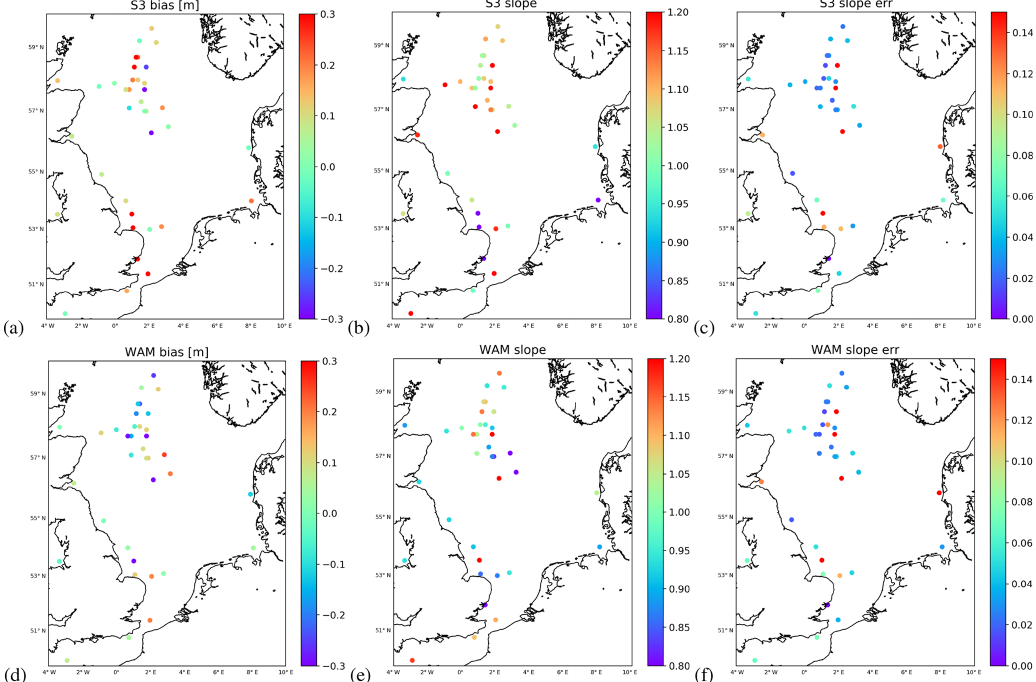
Figure 6. Colour coded biases (a, d) and calibration factors (b, e) derived by triple collocation for the Sentinel-3A altimeter (a, b, c) and WAM model wave heights (d, e, f) . The right column (c, f) gives the uncertainties in the slope estimations derived using the approach in Sect. 2.2 as standard